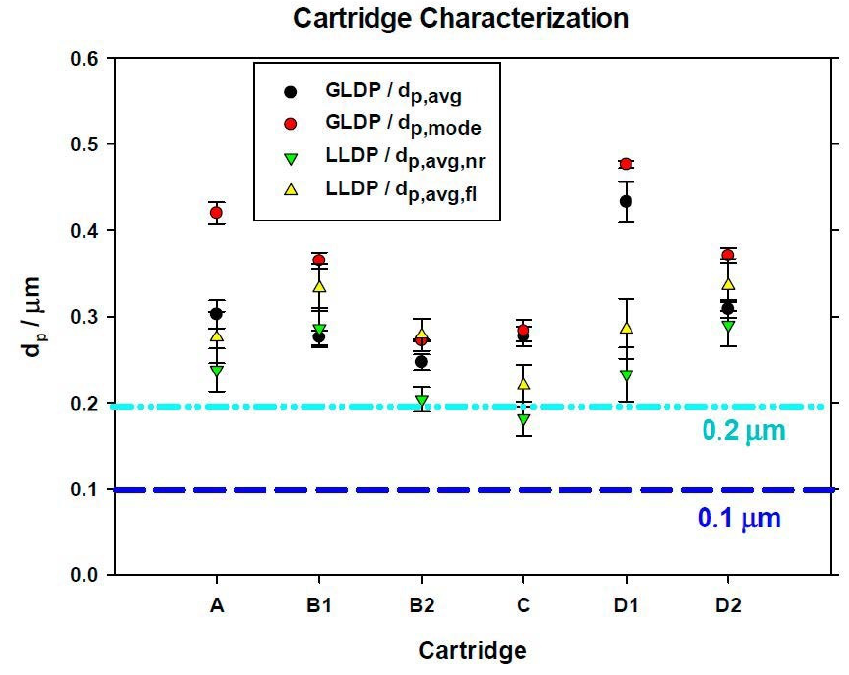
Figure 6. Comparison of porosimetric results for all cartridges studied.